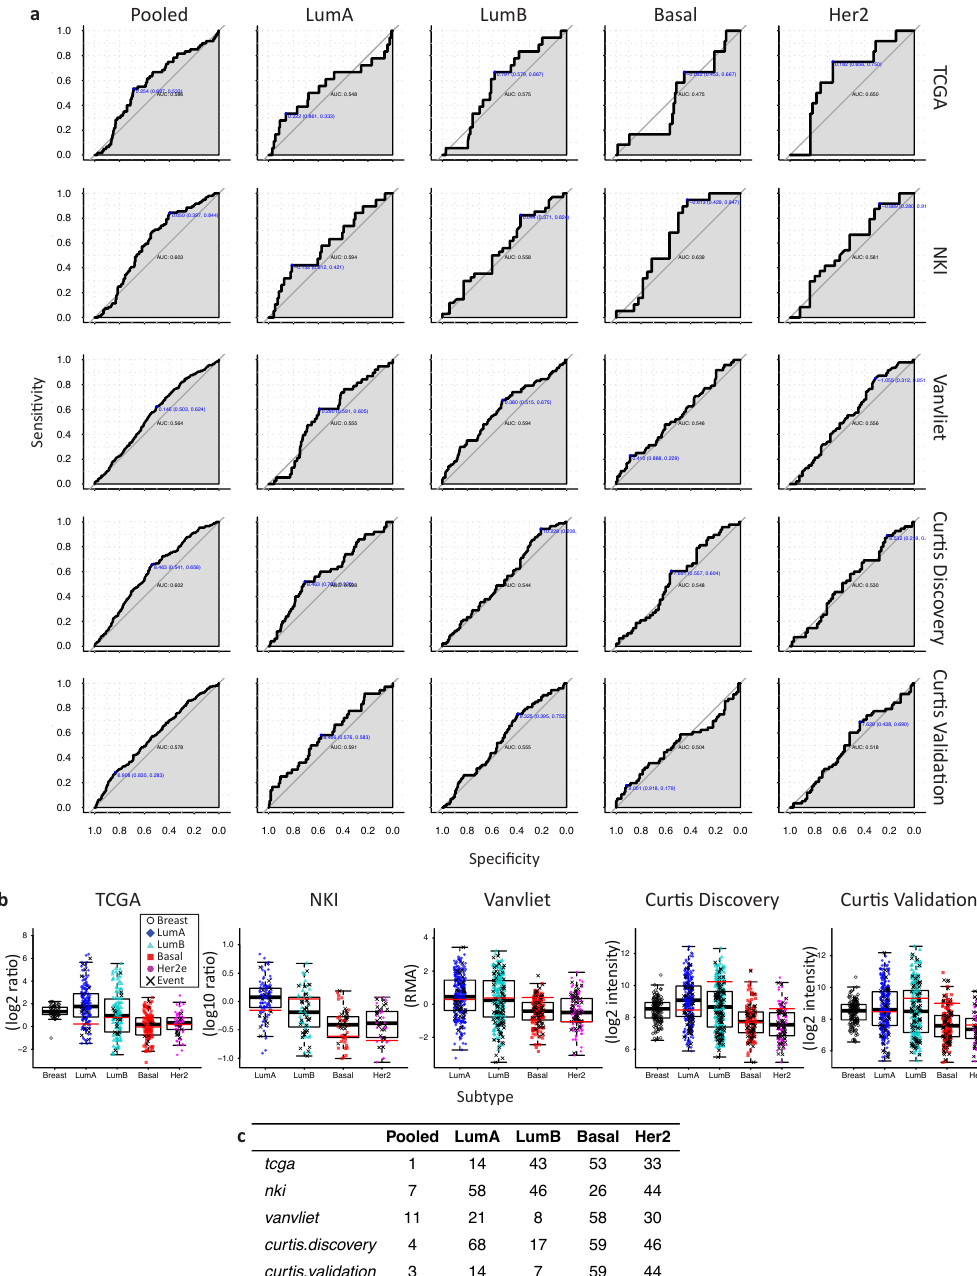
Figure A8. ( a ) Determination of the best cutoff for GJA1 using ROC curves in individual subtypes of breast cancer. ROC curves evaluating the sensitivity vs. the specificity of GJA1 as a marker of prognostic (occurrence of events in five years after tumor removal) in pooled tumors and each individual subtype of breast cancer of five datasets (TCGA, NKI, Vanvliet and Curtis discovery and Curtis validation). AUC, Area under the curve. The best cutoff is given in blue and is used in a subsequent survival analysis in Figure A9. ( b ) Expression of GJA1 in pooled tumors and individual subtypes in five datasets. The red lines indicate the cutoff as determined by the ROC curves. In the legend, “Breast” indicates adjacent normal breast tissue. X indicates tumors with subsequent recurrence events. ( c ) Rank of the GJA1 probe in pooled tumors and each individual subtype for five datasets. Rank given in percentile of the area under the ROC curve compared to all the other